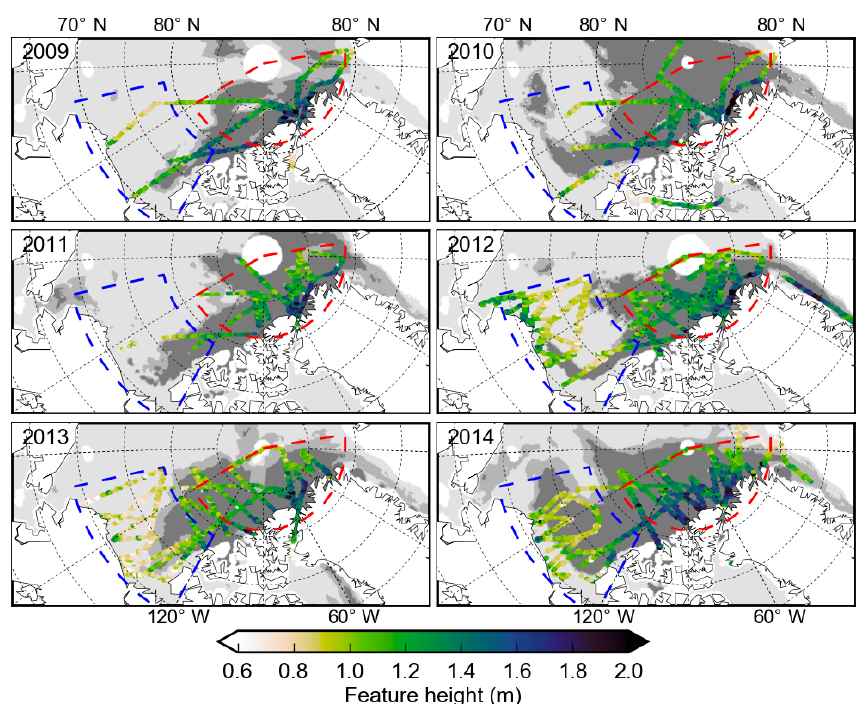
Figure 5. Surface feature height, h f , from 2009 to 2014, detected using a 20 cm elevation threshold. The dark grey (light grey) background indicates regions where more than 80% of the daily data within each year’s IceBridge sea ice campaign dates are estimated as MYI (FYI), while the medium grey indicates a mix of FYI and MYI. The red (blue) dashed lines represent the Central Arctic (Beaufort/Chukchi) regions used in this study. The data are plotted using hexagonal